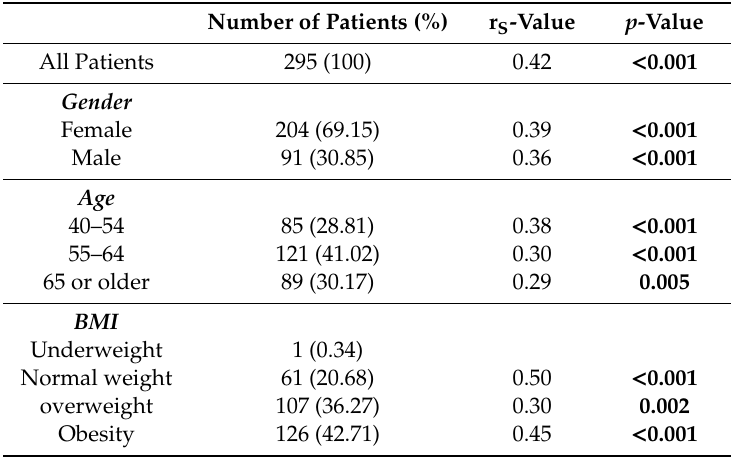
Table 2. Spearman’s correlation between the sti ff ness index and cardiovascular risk based Heart Risk Calculator in groups divided by gender, age and body mass index. BMI = body mass index; p -value < 0.05 is indicated in bold.